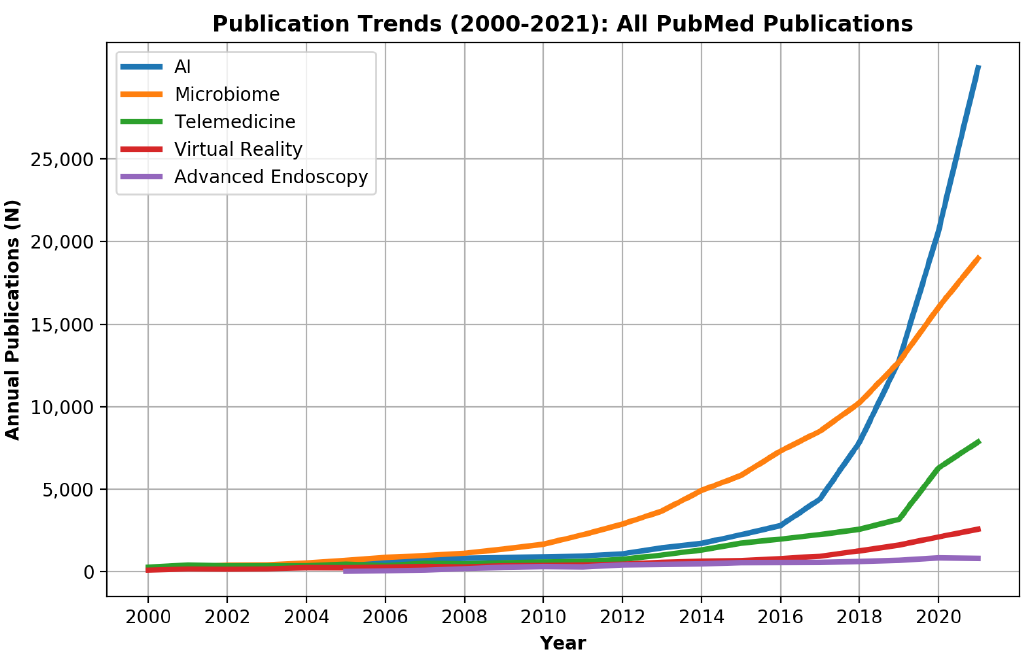
Figure 1. Publication trends of innovation research fields (artificial intelligence (AI), virtual reality (VR), telemedicine, the microbiome, and advanced endoscopy) in the medical field during 2000–2021.